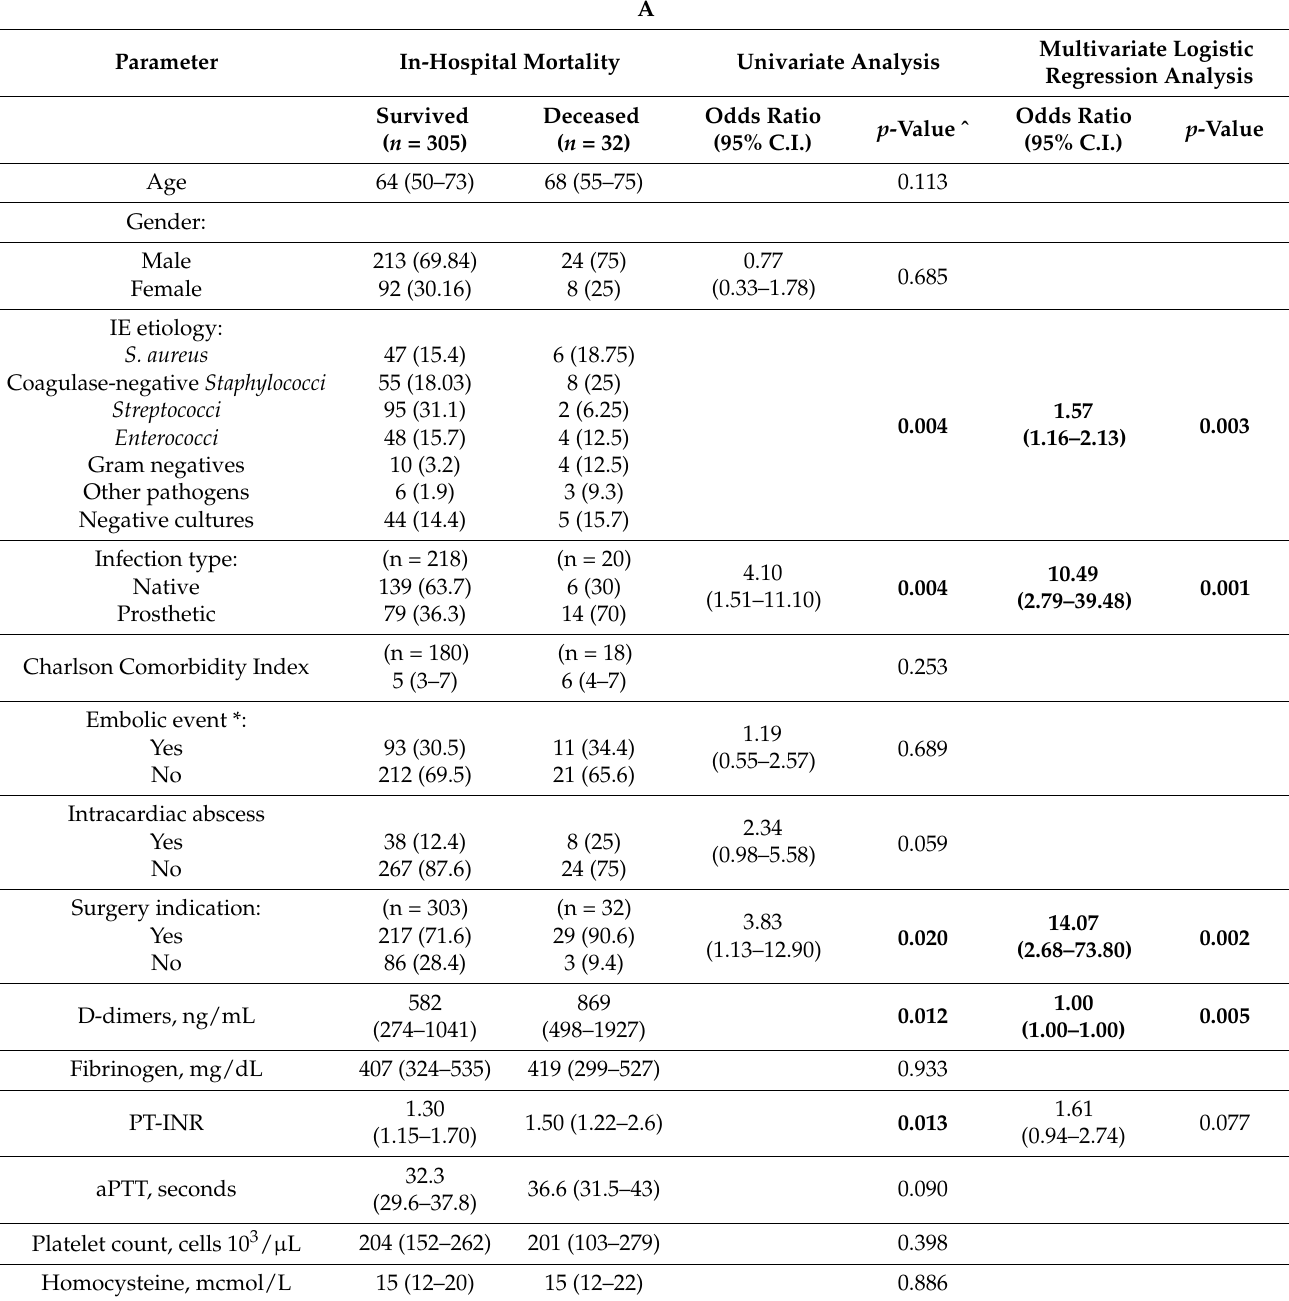
Table 3. Parameters associated with in-hospital mortality (panel A) and 1-year mortality (panel